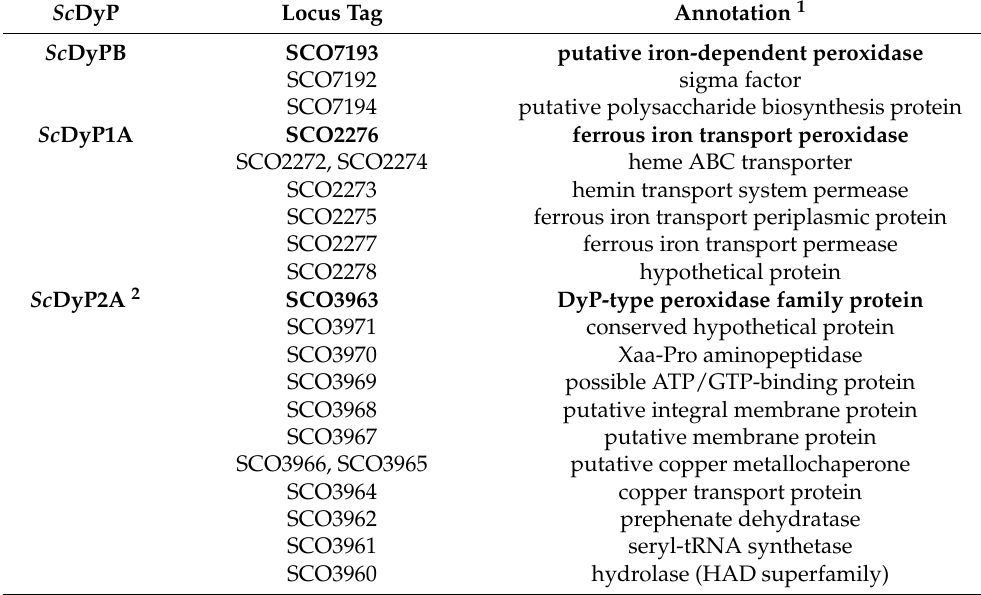
Table 1. The annotations of DyP-type peroxidases of S. coelicolor A3(2) and their corresponding operon neighbors, as assigned in the public databases. Sc DyP Locus